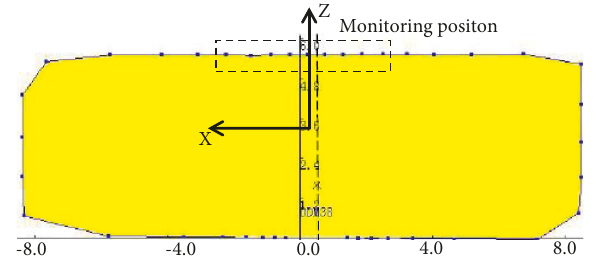
Figure 7: The layout of the monitoring points.